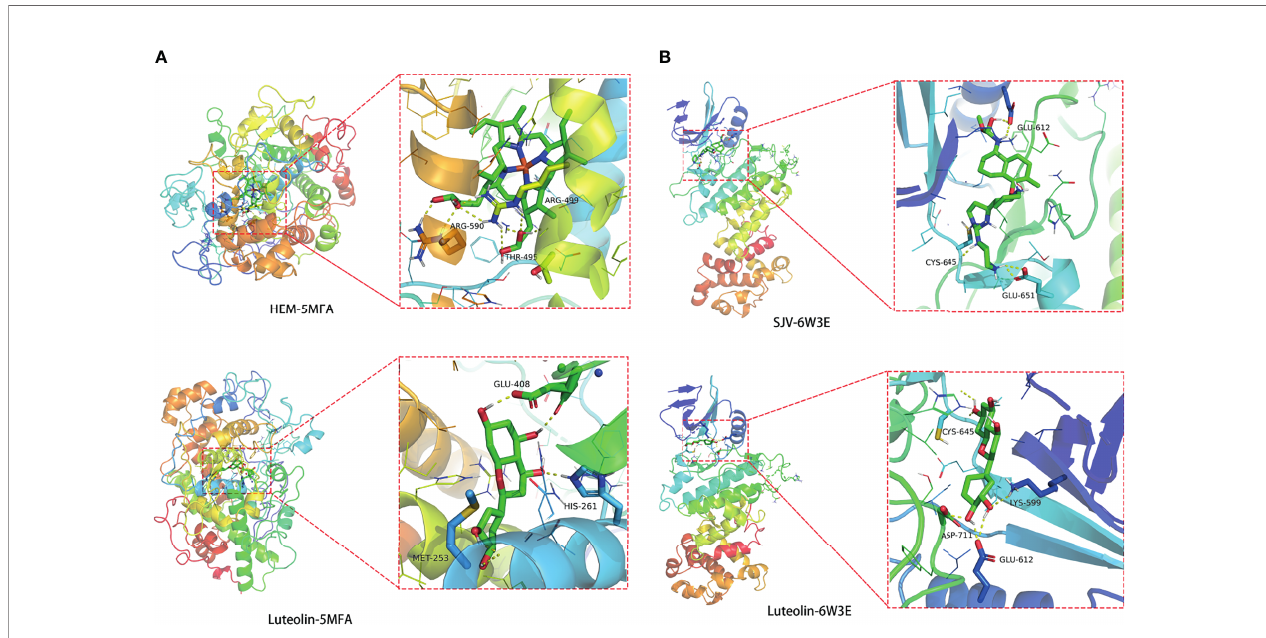
FIGURE 8 | Molecular docking fi ndings of luteolin in treating PC and COVID-19, as revealed in MPO-5MFA (A) and FOS-6W3E (B)